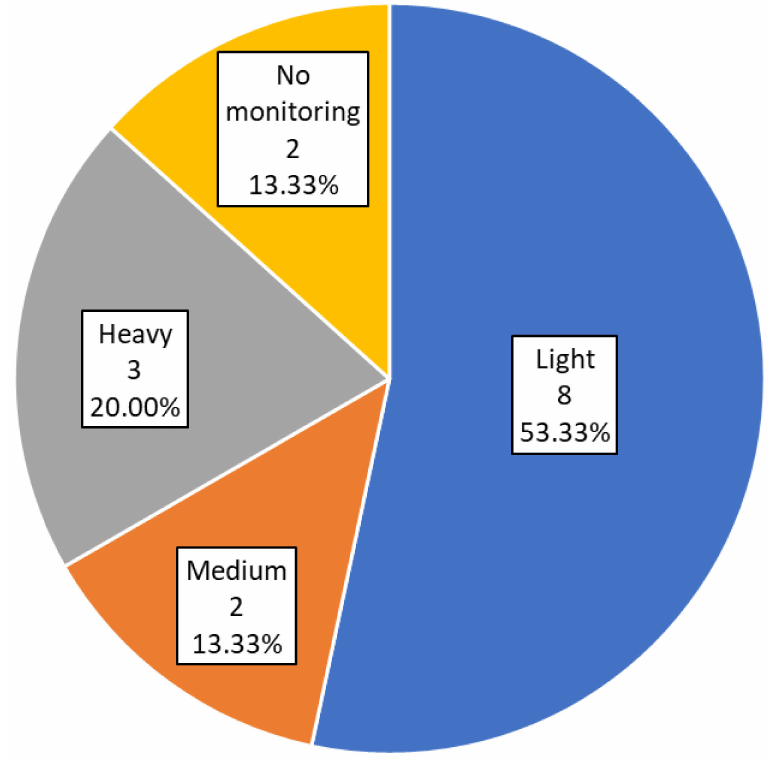
Figure 3. Monitoring results. Number and percentage of studies in each